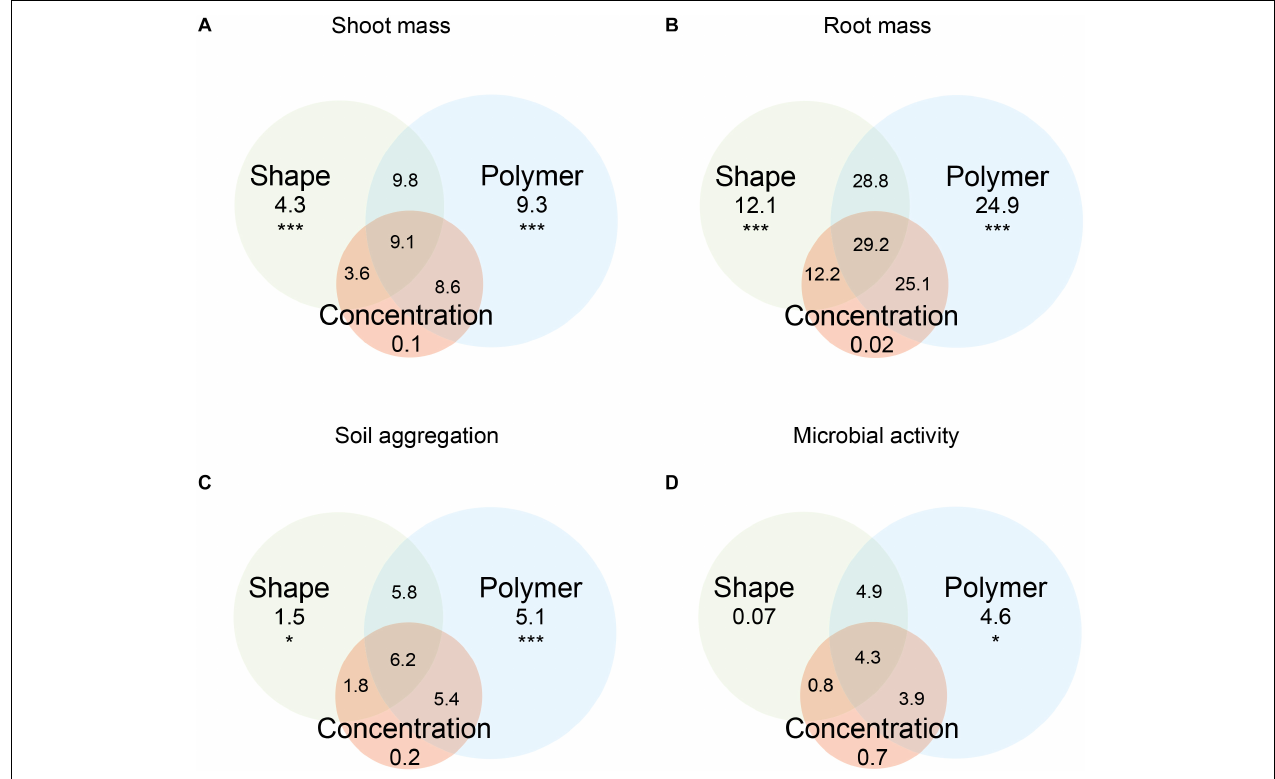
FIGURE 1 | Variation in (A) shoot mass, (B) root mass, (C) soil aggregation, and (D) microbial activity explained by microplastic shape, polymer type, concentration, and their combinations. Variance explained is based on adjusted R 2 (* p < 0.05, ** p < 0.01, and *** p < 0.001).